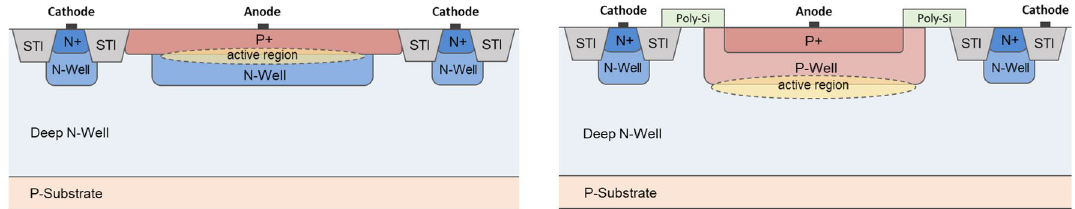
Figure 2. Layout of SPAD structures: P+/Nwell (left) and Pwell/Niso